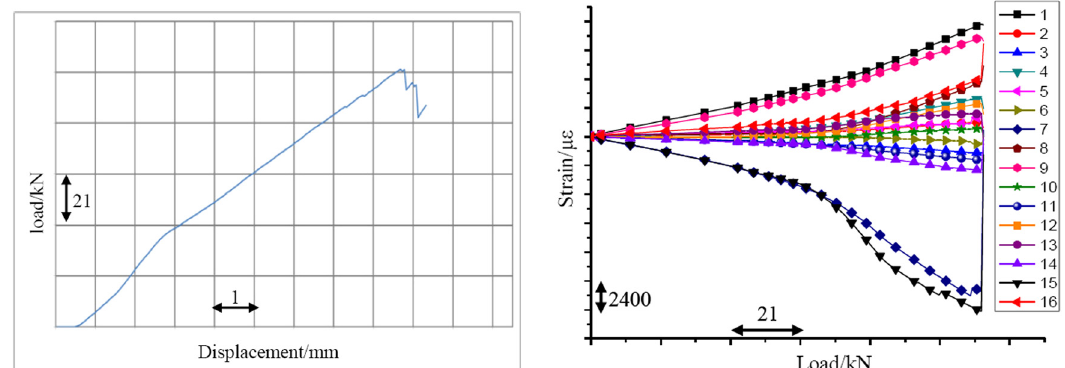
Figure 7: b2 - type test